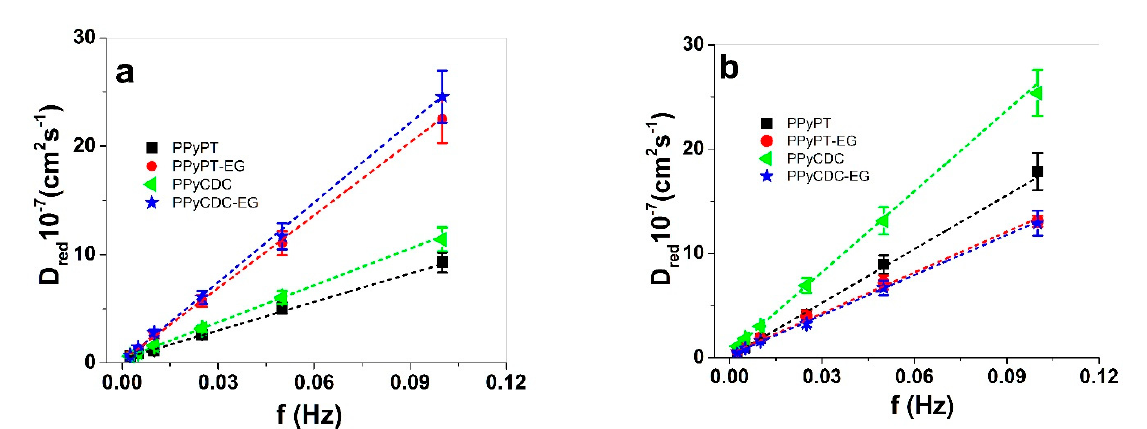
Figure 6. Diffusion coefficients at reduction D red calculated for PPyPT ( ■ ), PPyPT-EG ( ● ), PPyCDC ( ◄ ) and PPyCDC-EG ( ★ ) showing in ( a ), in NaClO 4 -PC and ( b ), NaClO 4 -aq electrolyte against applied frequencies f (0.0025 Hz to 0.1 Hz). The dashed lines represent the linear fit and are shown only for orientation.